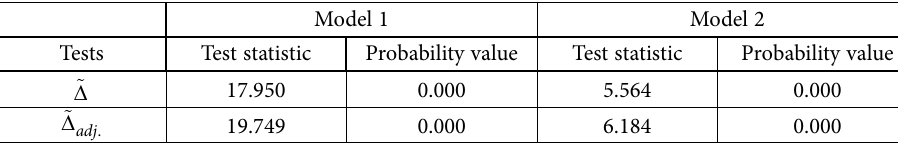
Table 4. Results of homogeneity tests